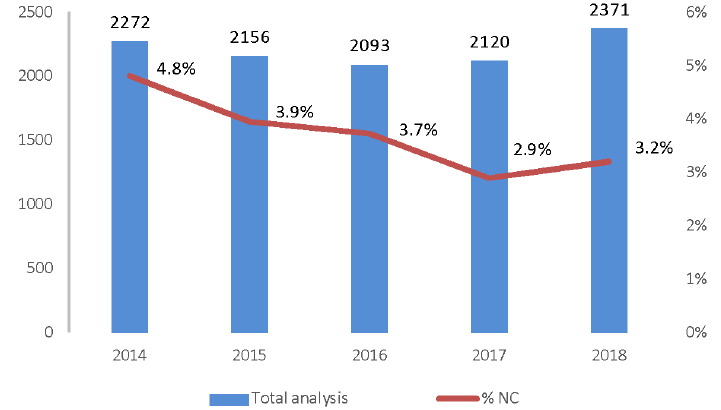
Figure 3. Total samples analyzed and percentage of non-compliant samples.